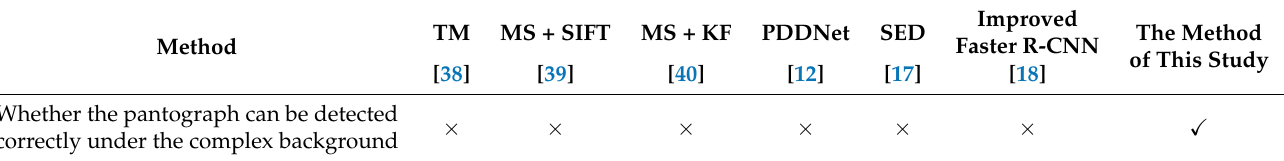
Table 1. Performance of different algorithms when dealing with complex backgrounds.